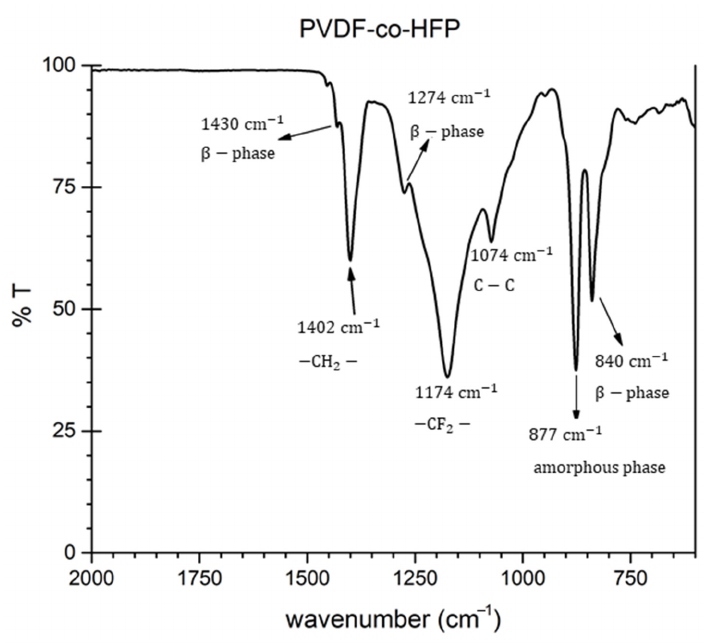
Figure 12. FTIR spectrum of the PVDF-co-HFP electrospun fibers.